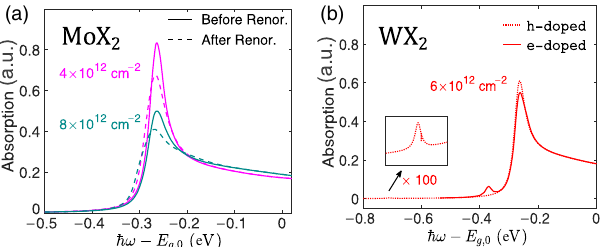
FIG. 9. The renormalized absorption spectrum of direct ex- citons in ML-MoX 2 and in the case of hole doping. (a) The case of electron-doped ML-MoX 2 before (solid lines) and after (dashed lines) renormalization. The dynamical sideband is not seen. (b) The case of electron-doped (solid line) and hole-doped (dotted line) ML-WX 2 . The dynamical sideband is negligible for hole doping, as highlighted in the magnified box. It emerges about 400 meV below the exciton line because of the large valence-band